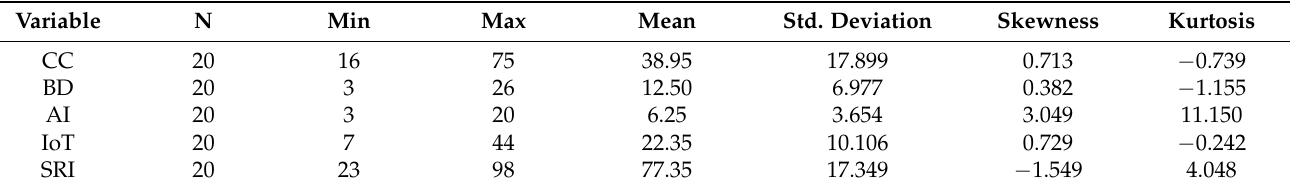
Table 2. Descriptive